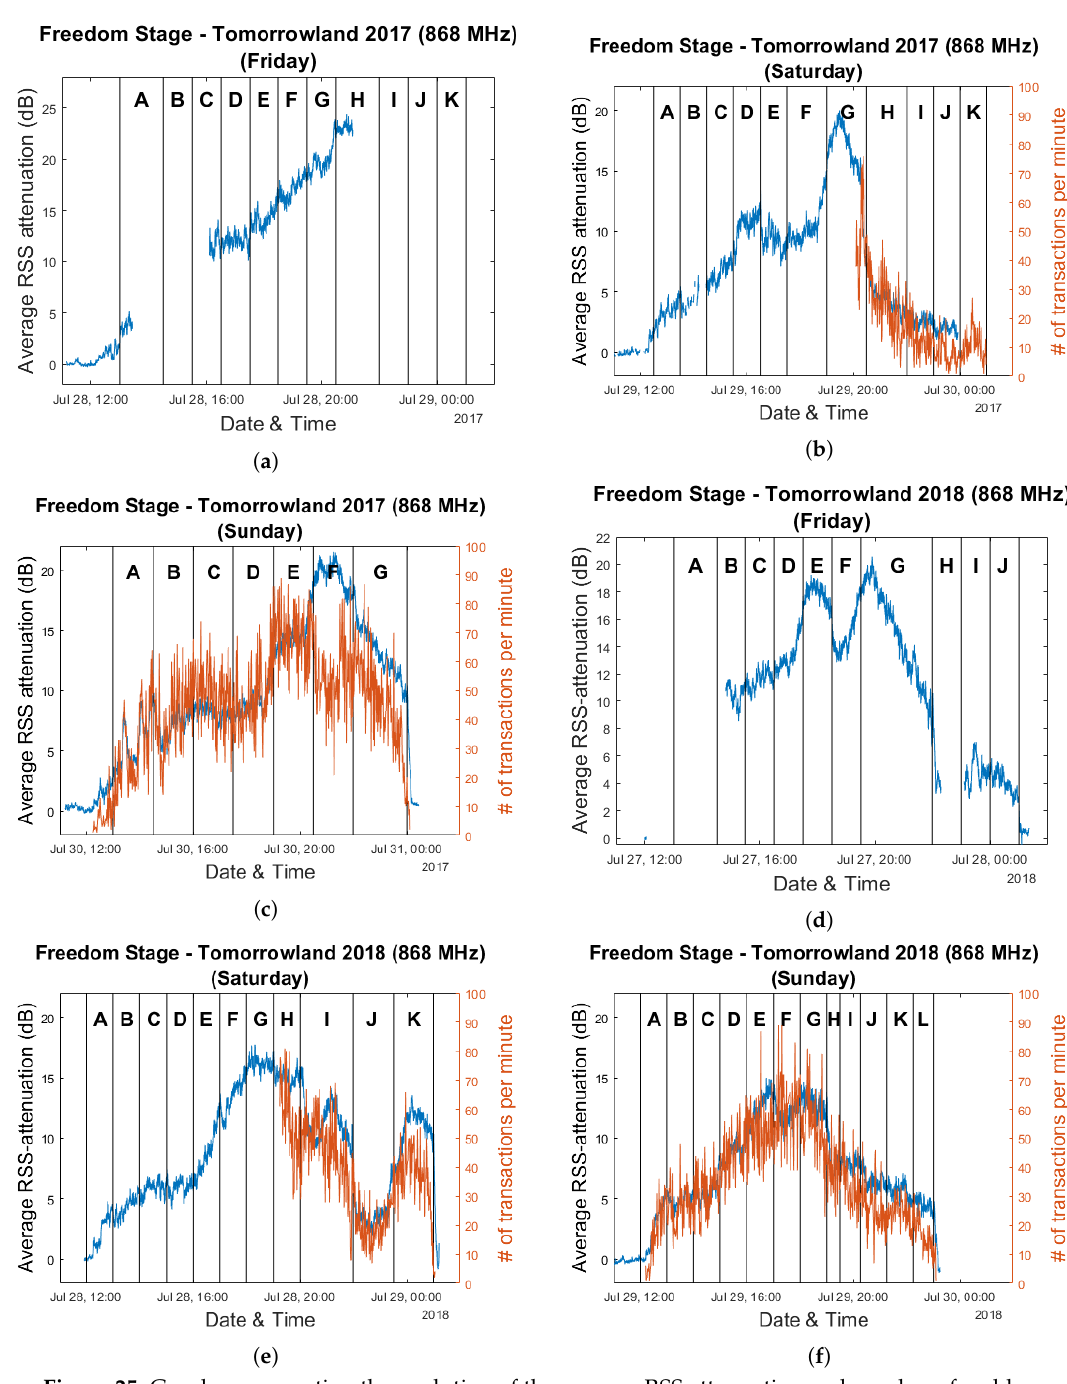
Figure 25. Graphs representing the evolution of the average RSS attenuation and number of cashless transactions per minute for the 2017 and 2018 editions of the Tomorrowland festival within the Freedom Stage environment. Plots ( a – c ) are based on data collected on Friday 28 July 2017, Saturday 29 July 2017 and Sunday 30 July 2017. Plots ( d – f ) are based on data collected on Friday 27 July 2018,